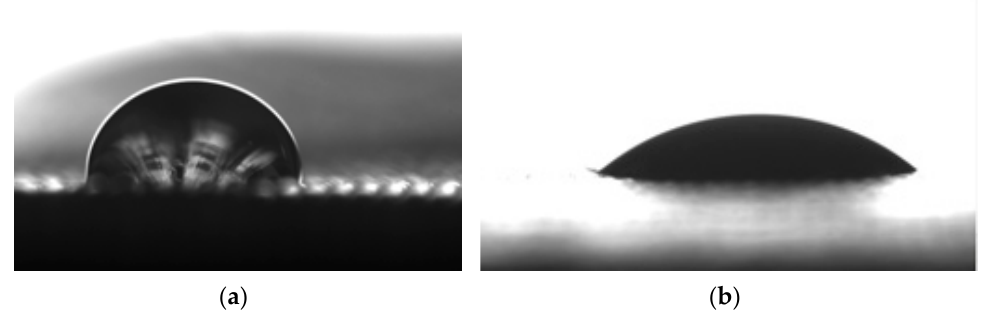
Figure 16. Contact angle measurement results ( a ) PLA object—sample 18, ( b ) MED610 object— sample 29. Table 4. Contact angle measurement results for sample—18, PLA obejct. Calculated feature Image in Print Direction